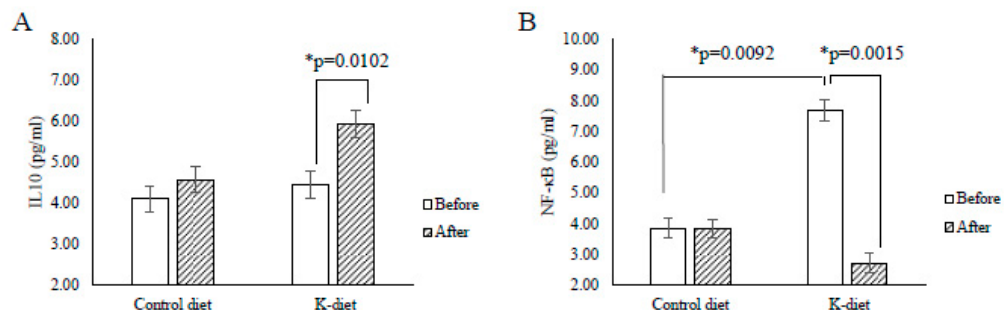
Figure 1. Changes in cytokine levels due to K-diet consumption. ( A ) Interleukin (IL)-10 levels significantly increased in the K-diet group, but not in the control group after the 2-week dietary intervention. ( B ) Before the intervention, the average nuclear factor kappa B (NF- κ B) levels in the K-diet group were significantly higher when compared to that in the control diet group. After the dietary intervention, NF- κ B levels were significantly reduced only in the K-diet group. All values are given as mean ± SE ( n = 5). * p < 0.05 by paired t -test. Table 6. Comparison of inflammatory markers before and after the intervention. K-food Diet ( n = 5)